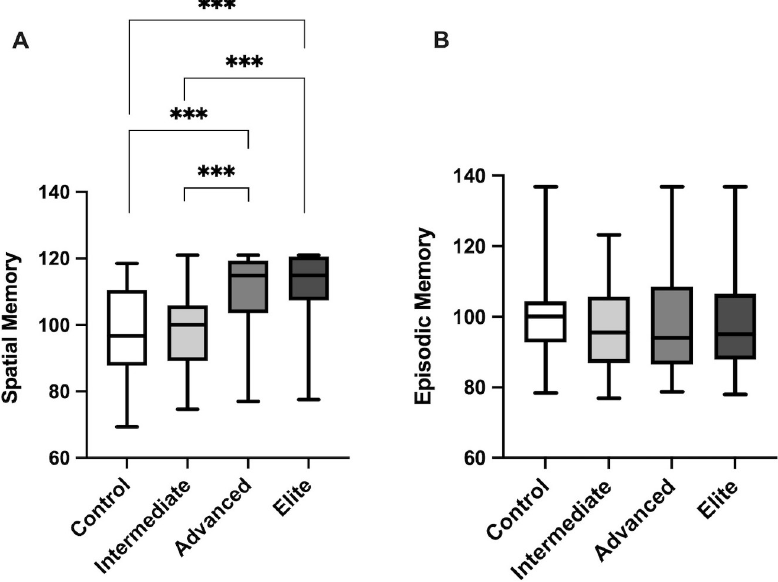
Fig 2. Average score on SAM autobiographical memory measure across groups. A boxplot demonstrating mean, minimum, and max values for A) spatial memory, B) episodic memory. Error bars reflect SD. ��� reflects p <